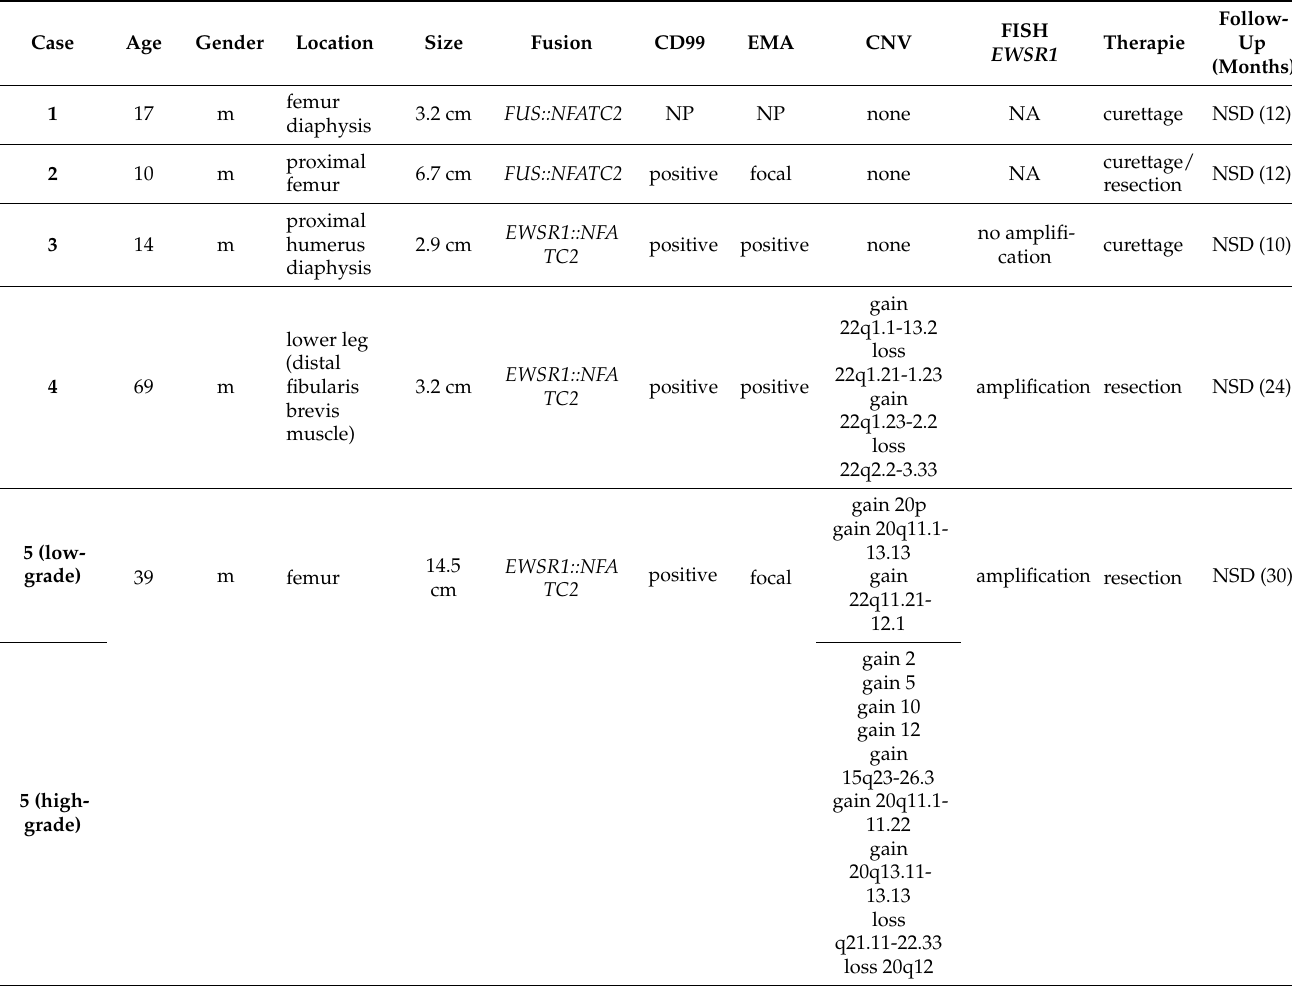
Table 1. Clinical, immunohistochemical, and molecular data of all